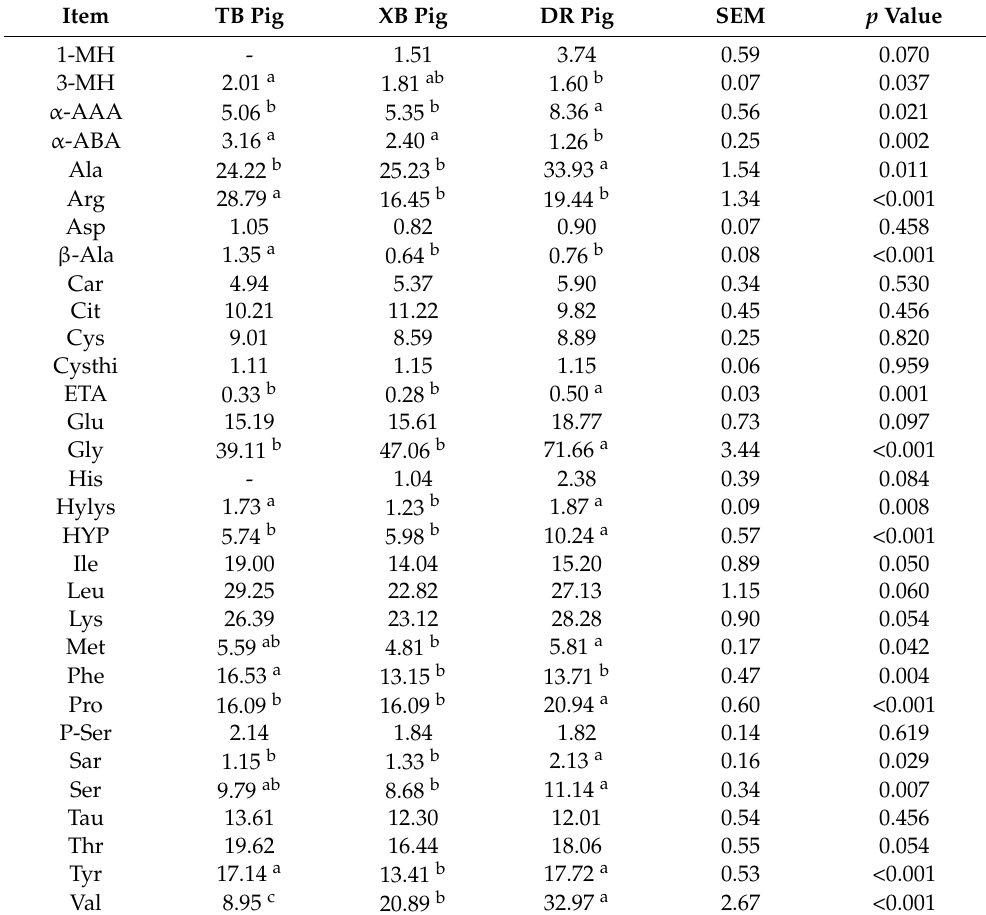
Table 7. Plasma free amino acids composition of three pig breeds at 185 days of age ( µ